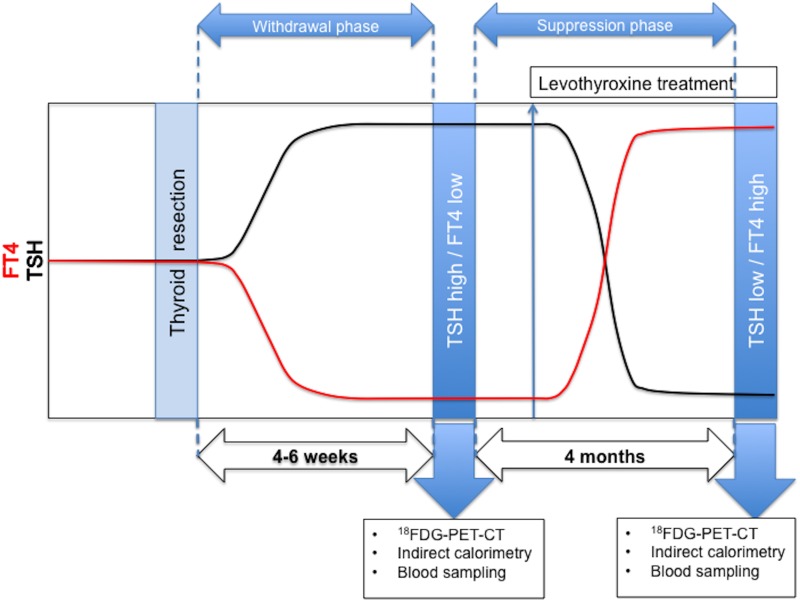
Schematic representation of study measurements after total thyroidectomy in the Maastricht University Medical Centre.Blue arrows indicate moment of study measurements. FT4 indicates free thyroxine, TSH indicates thyroid-stimulating hormone, levothyroxine treatment indicates pharmacological levothyroxine suppletion that suppresses endogenous TSH. I131 indicates radioactive iodine, used for radioactive ablation therapy of thyroid gland remnants after thyroid gland resection for well-differentiated thyroid carcinoma. I124 indicates a proton-rich isotope of iodine used as a radiochemical for determination of thyroid gland remnants after thyroid gland resection for well-differentiated thyroid carcinoma.